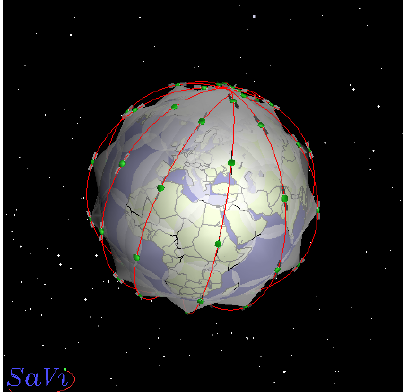
Figure 2. Iridium constellation and its coverage of the Earth.